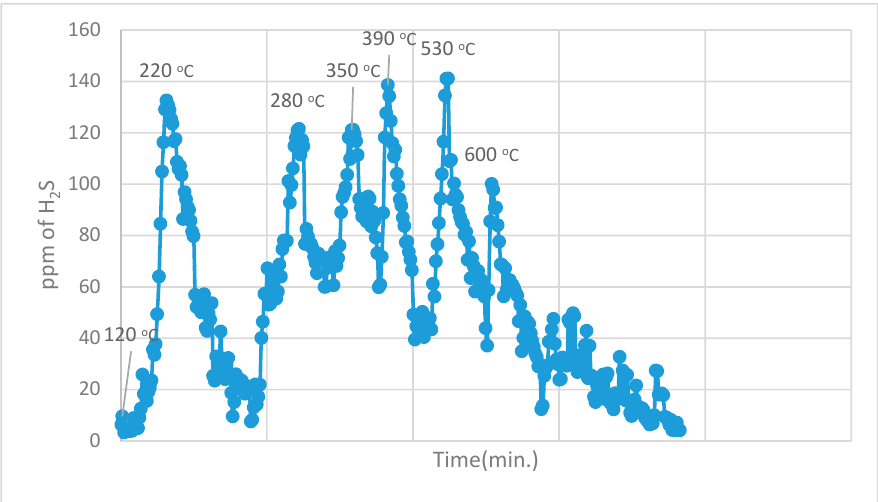
Time(min.) Figure 5. TPR of treated silverdale coal. Figure 5. TPR of treated silverdale coal. Figure 5. TPR of treated silverdale